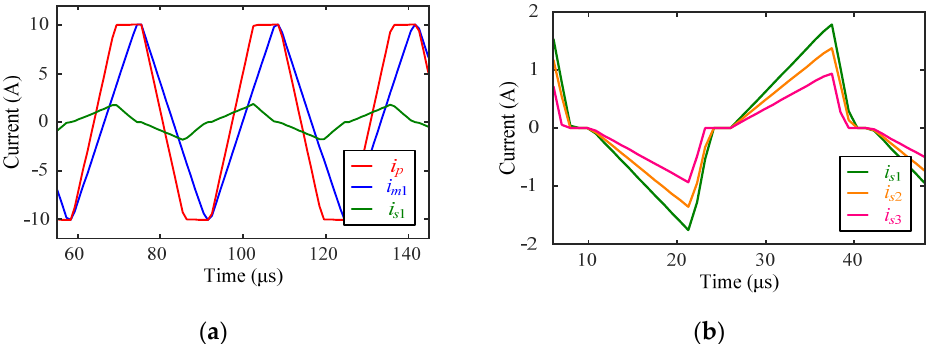
Figure 5. Waveforms of the current transformer. ( a ) Waveforms of the current transformer for the first module. ( b ) Secondary side current of each output module.